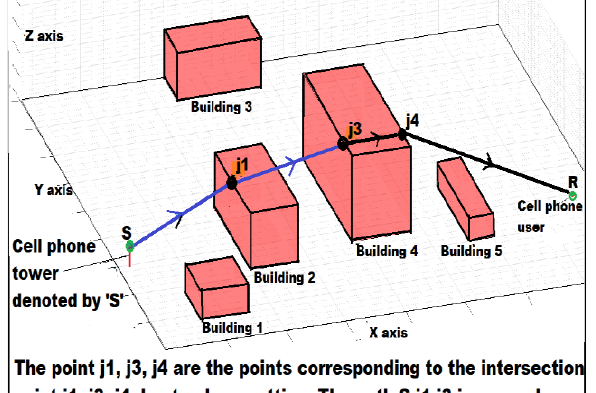
Figure 9. Signal path due to reflection(S. Bharadwaj et al.,